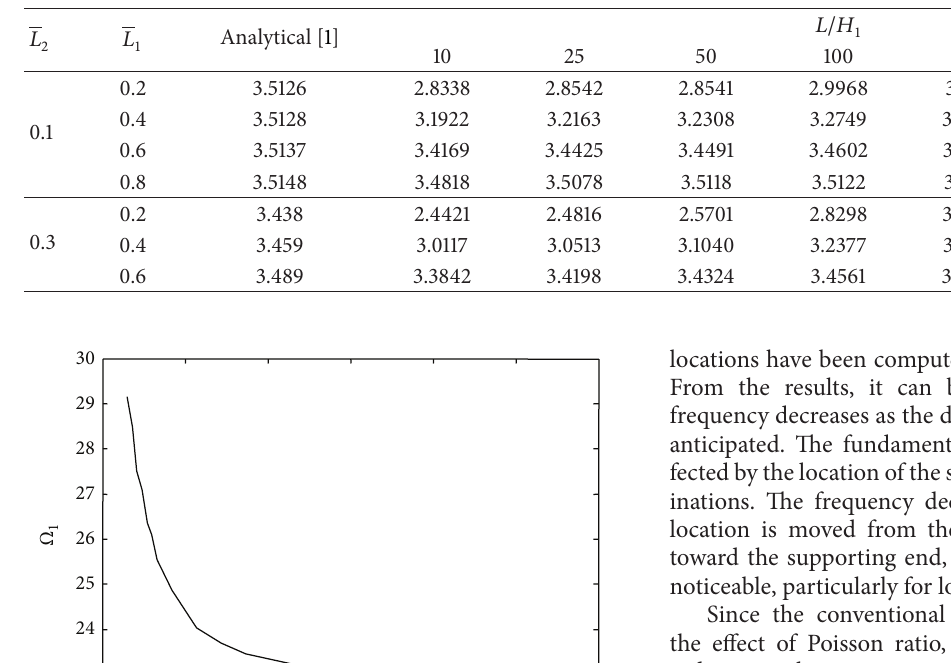
Table 1: Nondimensional fundamental frequency ( Ω 1 ) of an I:C-F beam with a midplane delamination.